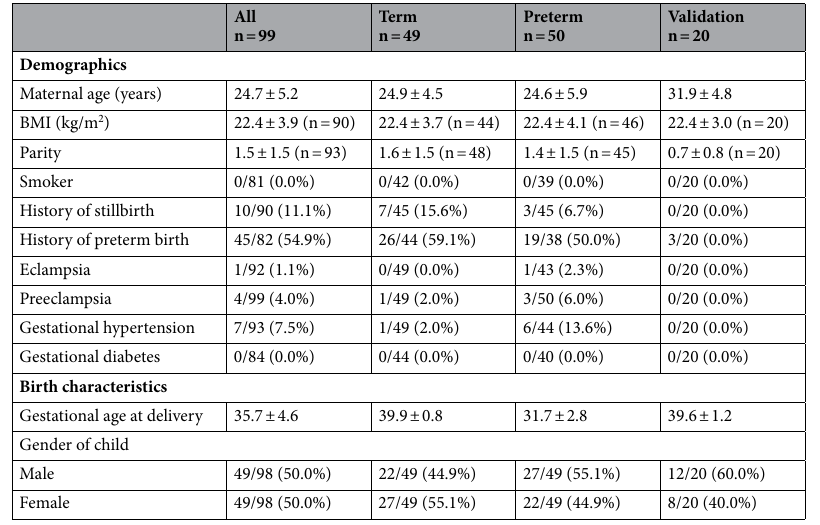
Table 1. Demographics and birth characteristics. Values are mean ± standard